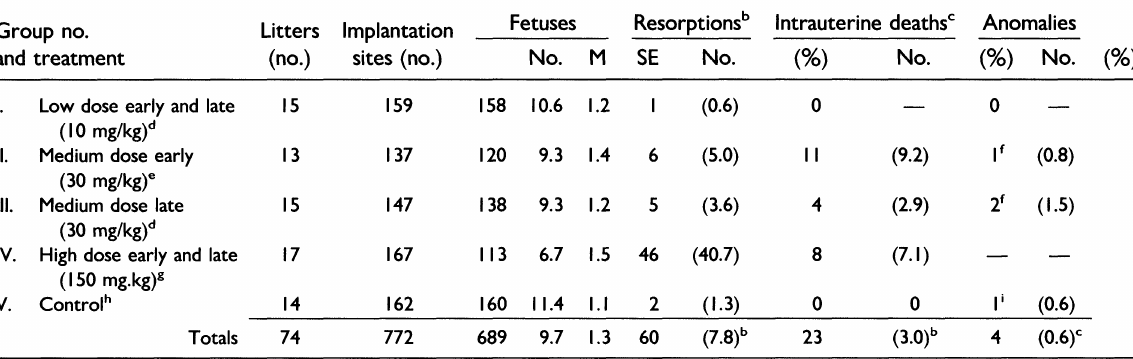
Intrauterine deaths Anomalies